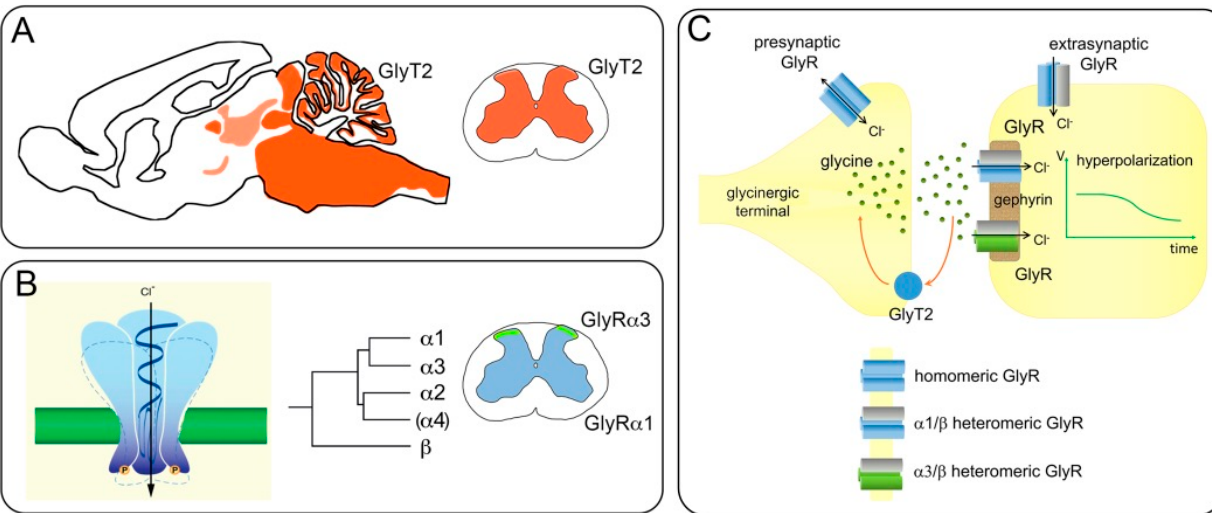
Figure 1. Principles of glycinergic inhibition. ( A ) Schematic sagittal mouse brain section illustrating the distribution of glycinergic innervation detected by GlyT2 staining (in red). High density innervation is found in the brainstem with particularly dense expression in the medulla oblongata and pons, and generally weaker expression in the midbrain and parts of the thalamus. Dense innervation is also found in the cerebellar cortex, the inferior colliculus, and the mesencephalic trigeminal nucleus. Cortex and hippocampus are virtually devoid of glycinergic innervation. In the spinal cord, glycinergic innervation is very widespread, with slightly less expression observed in the most dorsal laminae I and II. ( B ) Glycine receptors are chloride permeable heteropentameric ion channels, composed from a repertoire of five (in humans four) subunits each encoded by a separate gene ( α 4 is a pseudogene in humans). Each subunit is composed of a large extracellular domain followed by 4 transmembrane segments connected by loop structures and a short extracellular C-terminus (see also Figures 2A and 4). In the spinal cord, α 1 subunit immunoreactivity (blue) is found throughout the grey matter, but α 3 subunit expression (green) is highly and specifically enriched in lamina II. ( C ) Schematic representation of a glycinergic synapse. Glycine is released from a glycinergic terminal and binds to postsynaptic α / β heteromeric receptors anchored to the postsynaptic scaffolding protein gephyrin. Their activation by synaptic release causes an inhibitory postsynaptic potential. Glycine receptors are also found at extrasynaptic and presynaptic sites. Presynaptic glycine receptors lack β subunits and are not clustered by gephyrin. Activation of extrasynaptic glycine receptors cause a tonic inhibitory membrane current, whereas the activation of presynaptic glycine receptors may enhance transmitter release.